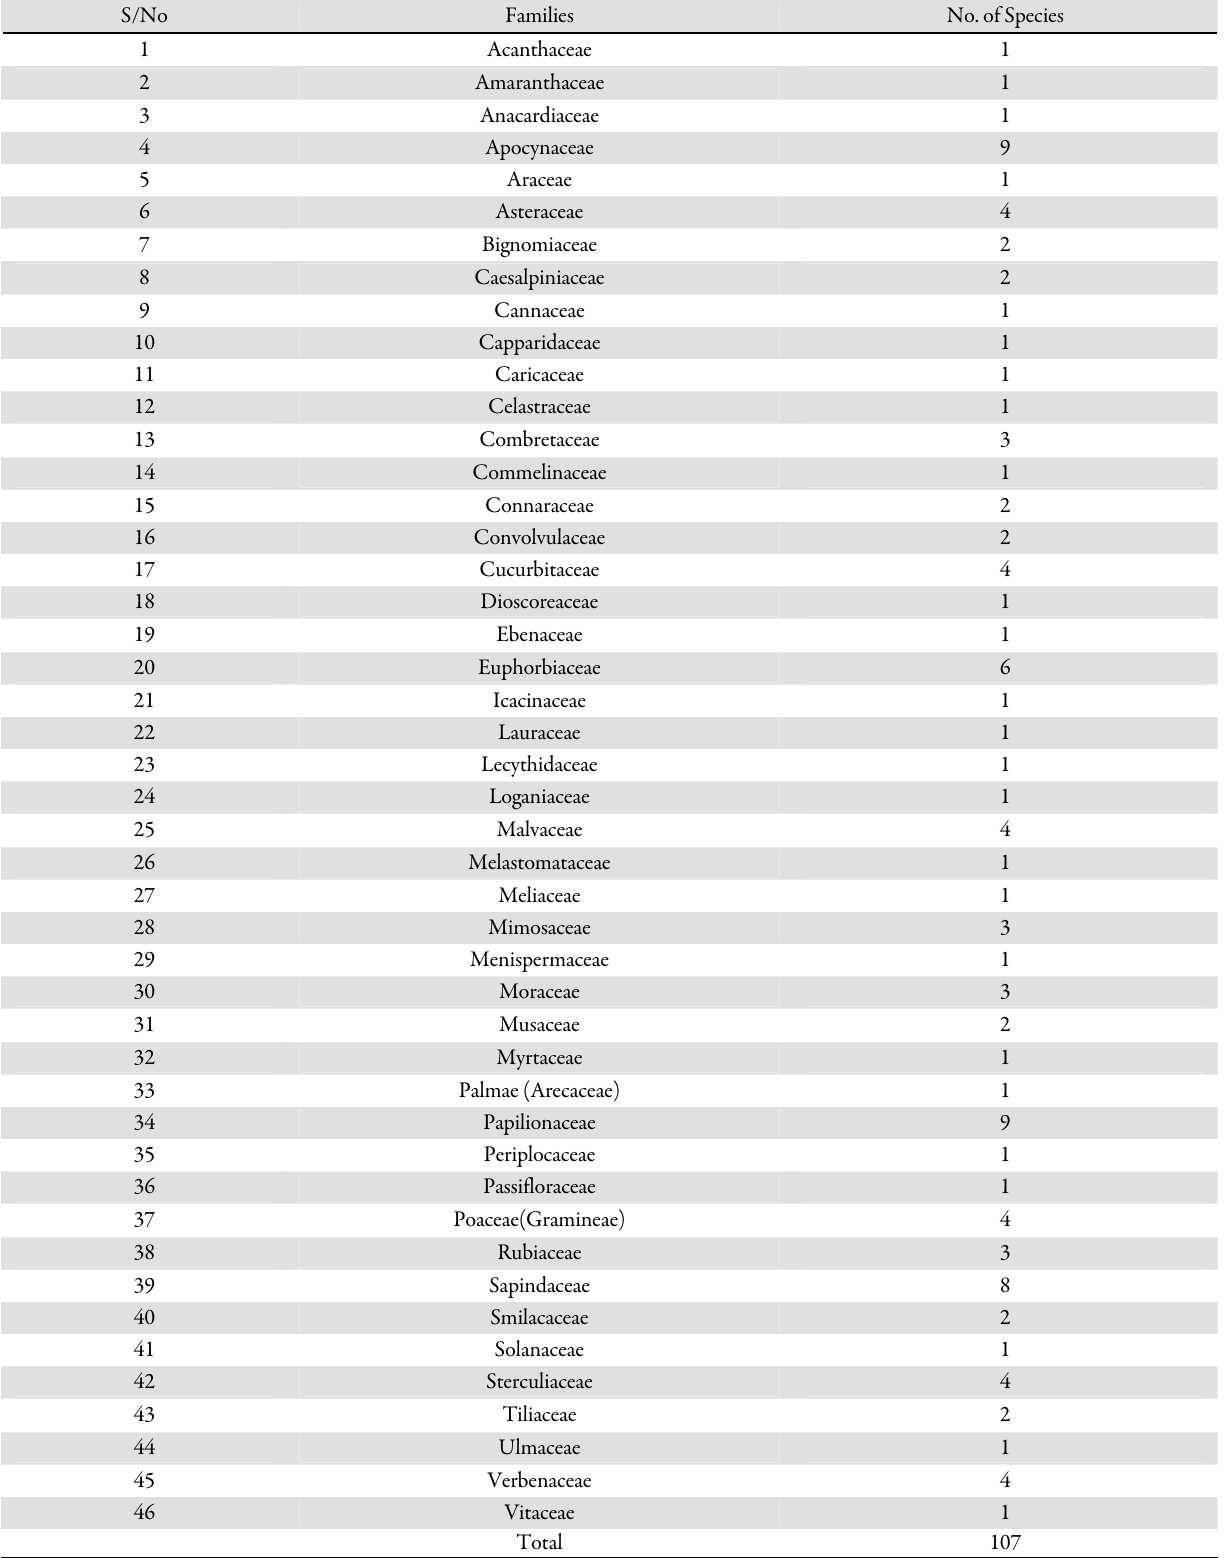
Table 1. Species distribution according to